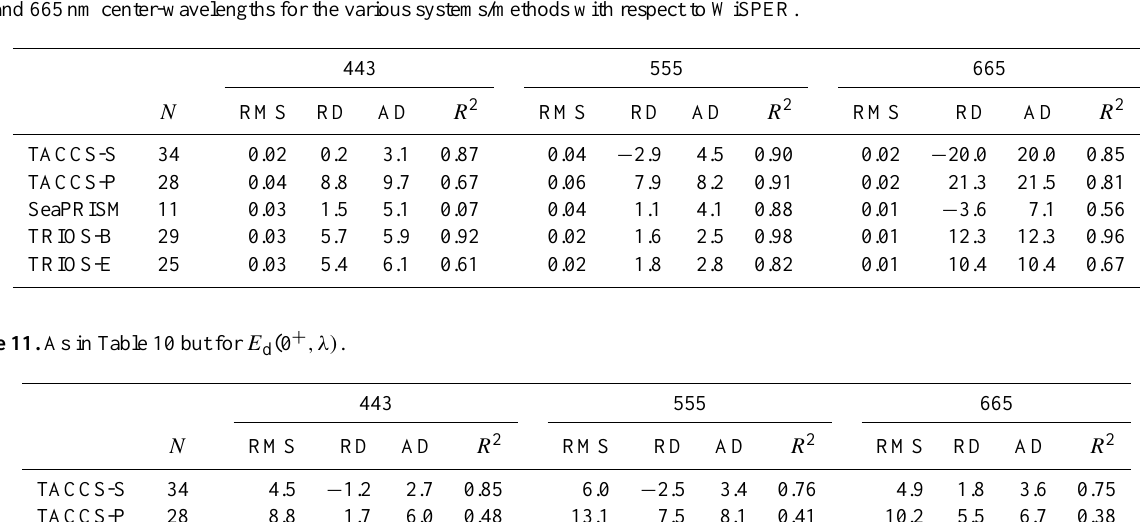
Table 10. Spectral values of the statistical indices (i.e. RMS, RD, AD and R 2 ) quantifying the inter-comparison results for L w (λ) at the 443, 555 and 665nm center-wavelengths for the various systems/methods with respect to WiSPER.